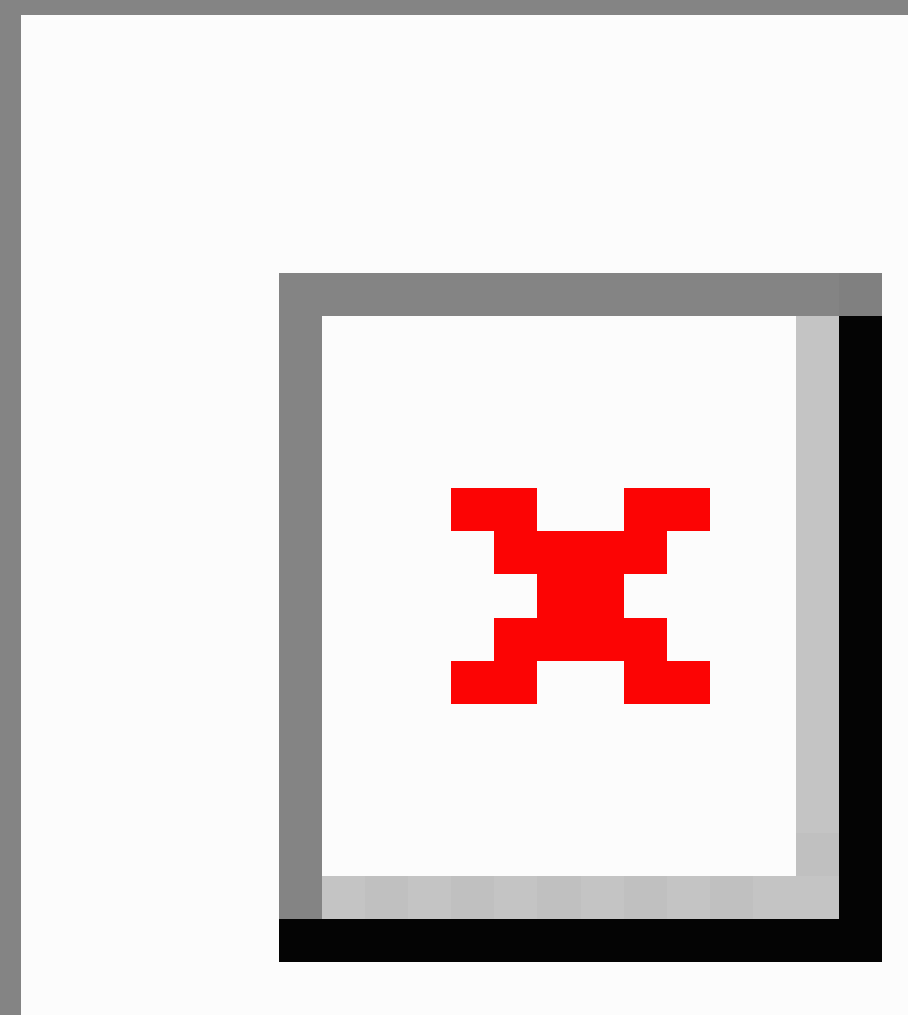
Figure 1. Selection process of the systematic